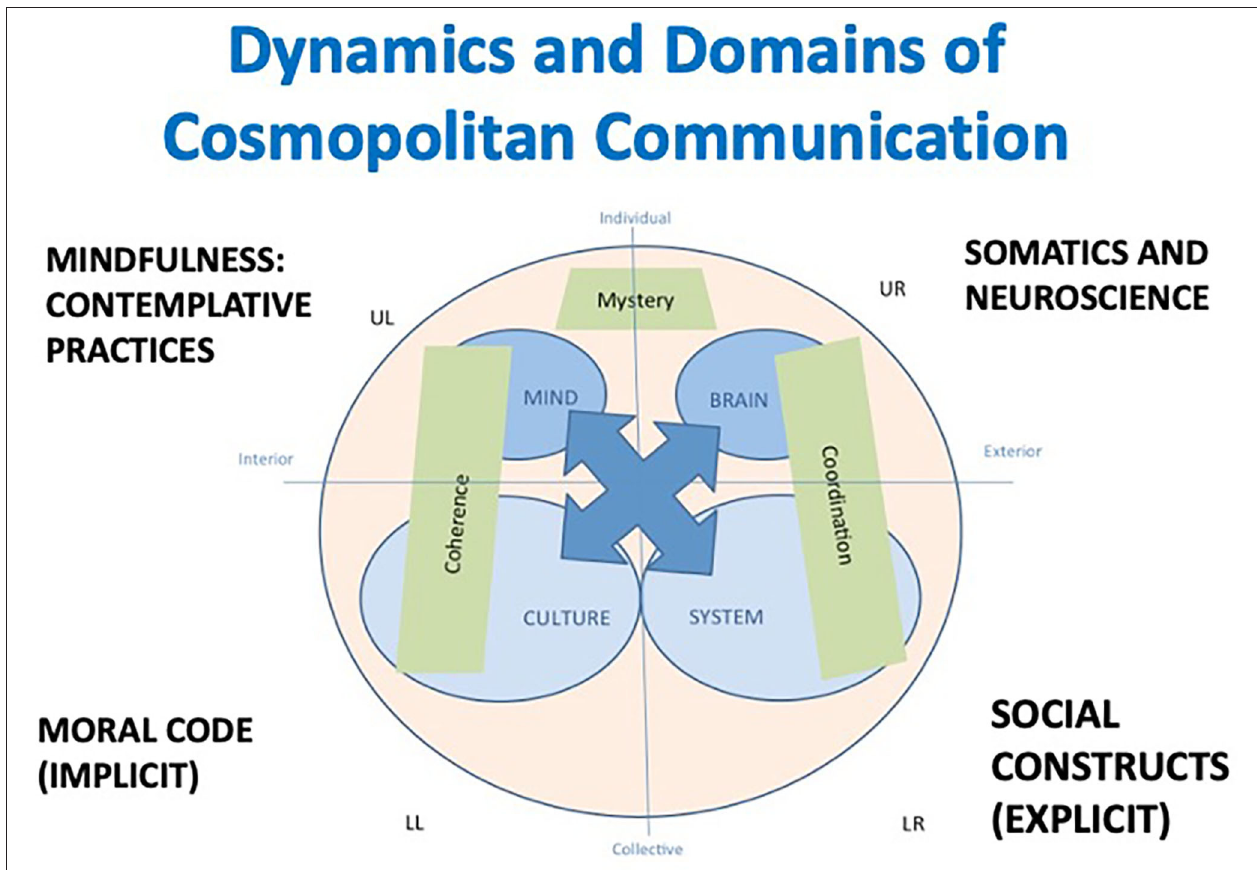
FIGURE 4 | The CMM storytelling model